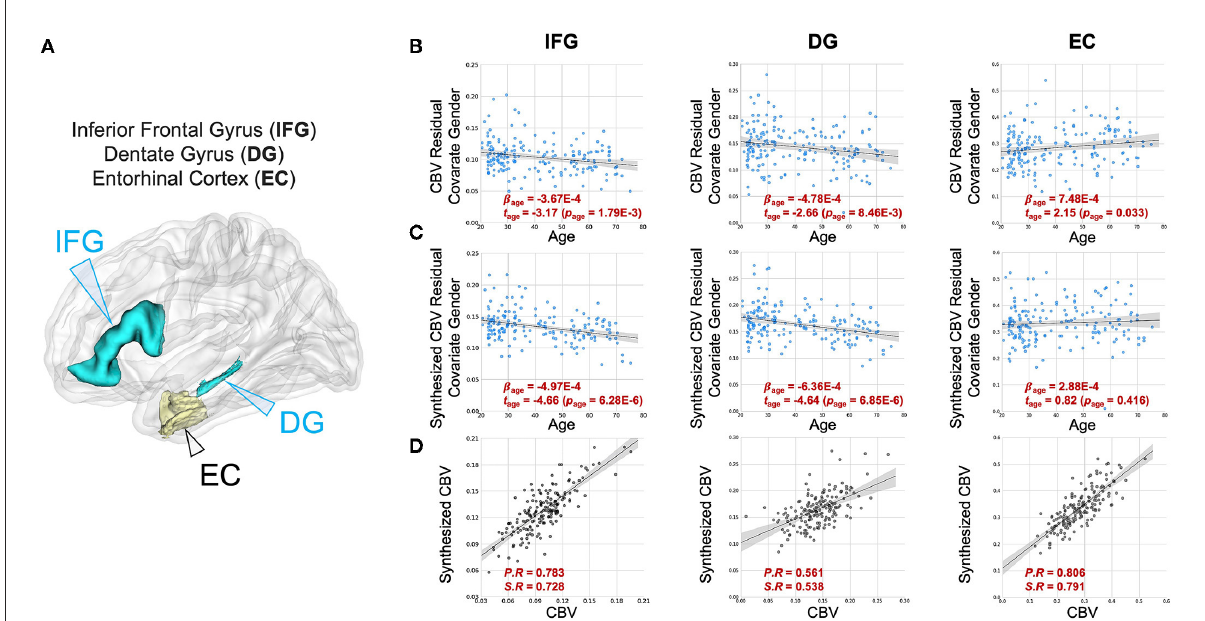
FIGURE5 DeepContrast maps age-related changes in brain regions vulnerable and resistant to aging. (A) A three-dimensional rendering of the inferior frontal gyrus (IFG), dentate gyrus (DG) and entorhinal cortex (EC) overlaid on a group-wise T1-weighted MRI template. (B) The age-related regressions of CBV maps over these regions demonstrate the aging-vulnerability of IFG and DG and the aging-resistance of EC. (C) The age-related regressions of synthesized CBV maps over the same regions demonstrated the same vulnerability or resistance to aging. (D) The scatter plots of the ROI-mean CBV vs. synthesized CBV values of the 177 participants further show the consistency of the two